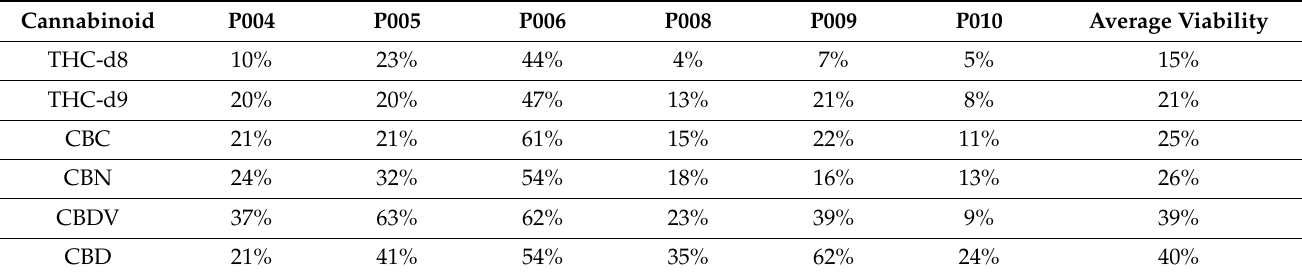
Table 2. Toxicity of cannabinoids on colon-polyp-derived